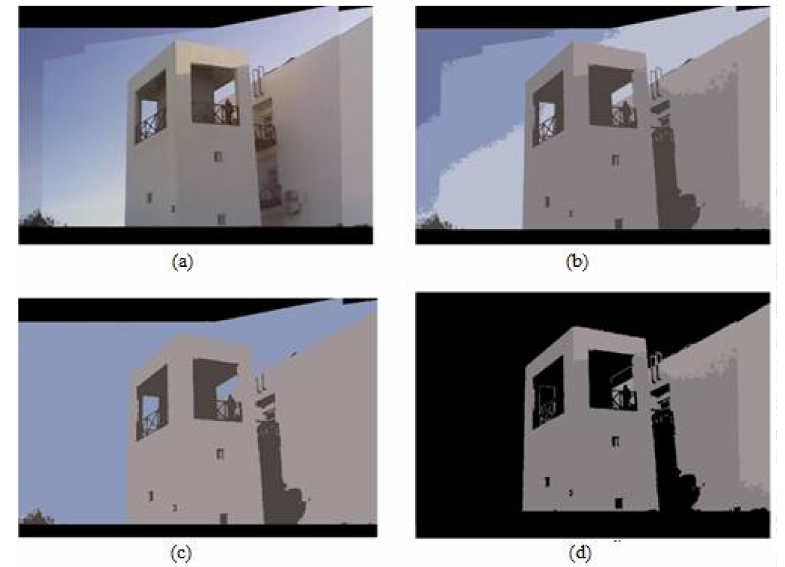
Figure 3. Building extraction process: ( a ) initial mosaic of campus building; ( b ) mean shift color segmentation result; ( c ) Segmented image after the merge of neighboring accepted classes; and ( d ) extraction of the building structure. Transitioning from ( c ) to ( d ) is essentially the segmentation process that removes the class that corresponds to the sky (blue value), as well as retaining the class with the largest number of pixels being assigned to it (assuming that the building is the largest structure in the